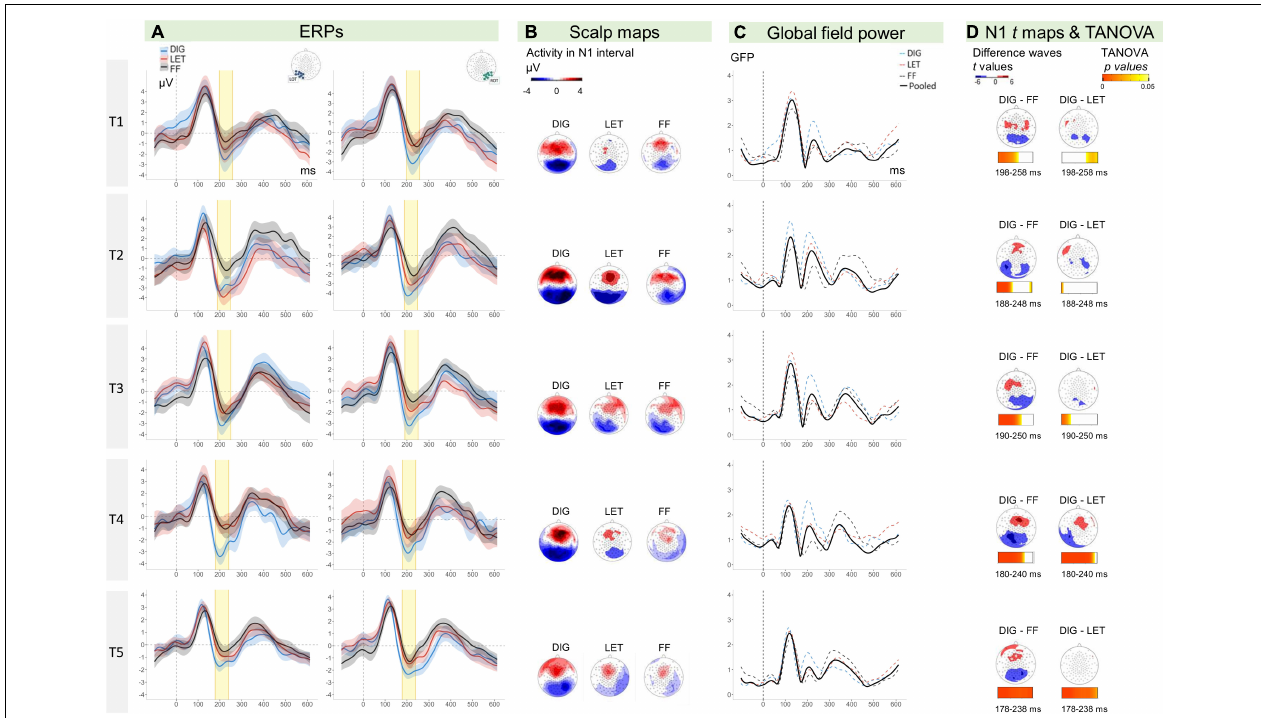
FIGURE 3 | (A) ERPs ( y -axis: µ V, x -axis: time in ms) for digits (blue lines), letters (red lines), and false fonts (black lines) with ribbons indicating 95% CIs (within-subject). Left hemispheric amplitudes are depicted on the left side and right hemispheric amplitudes on the right. The N1 time-window is highlighted in yellow. (B) Scalp topographies for digits, letters, and false fonts. (C) GFP for the average of the three conditions (black line), digits (dashed blue line), letters (dashed red line), false fonts (dashed black line). (D) Scalp maps show the distribution of t values for the difference between conditions tested against zero (color steps display only values from 6 to 4 and 4 to 2, corresponding to ± t values significant for current sample sizes at p < 0.05). The horizontal bars below show p values resulting from TANOVA permutation tests of differences in topographies between conditions across each data point of the N1 time intervals (T1: 198–258 ms, T2: 188–248 ms, T3: 190–250 ms, T4: 180–240 ms, and T5: 178–238 ms). The bar color map from light to darker orange indicates ps ranging from 0.05 to 0; the blank periods indicate non-significant ps > 0.05. ERPs, event-related potentials; CIs, confidence intervals; GFP, global field power; TANOVA, topographic analysis of variance; DIG, digits;